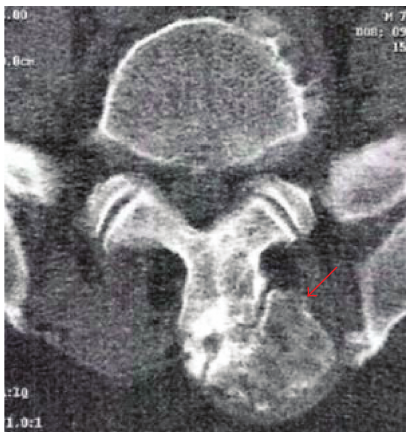
Figure 1: CT scan. Axial view showing a well-limited mass with a cartilage cap arising from the spinous process of L5 lateralized to the left (arrow).